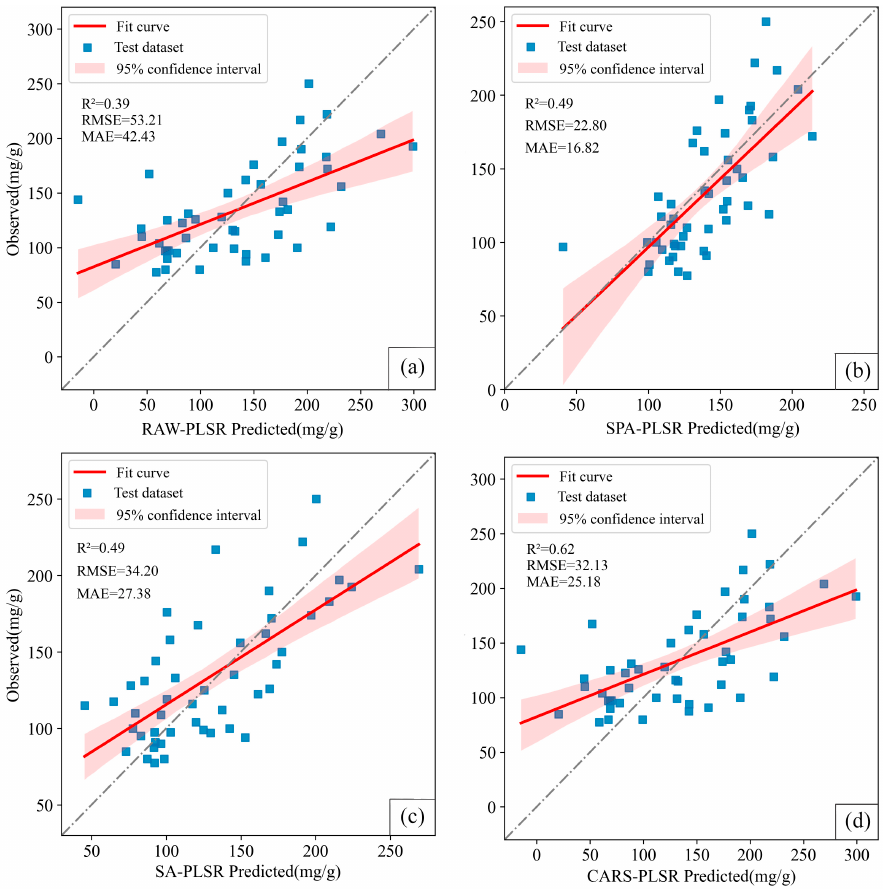
Figure 5. Comparison of predicted values and observed values for different combinations of dimen- sionality reduction and PLSR inversion models for soil available potassium content. ( a ) RAW–PLSR represents PLSR inversion based on raw spectrum. ( b ) SPA–PLSR represents PLSR inversion based on variables selected by successive projections algorithm ( c ) SA–PLSR represents PLSR inversion based on variables selected by simulated annealing ( d ) CARS–PLSR represents PLSR inversion based on variables selected by competitive adaptive reweighted sampling.